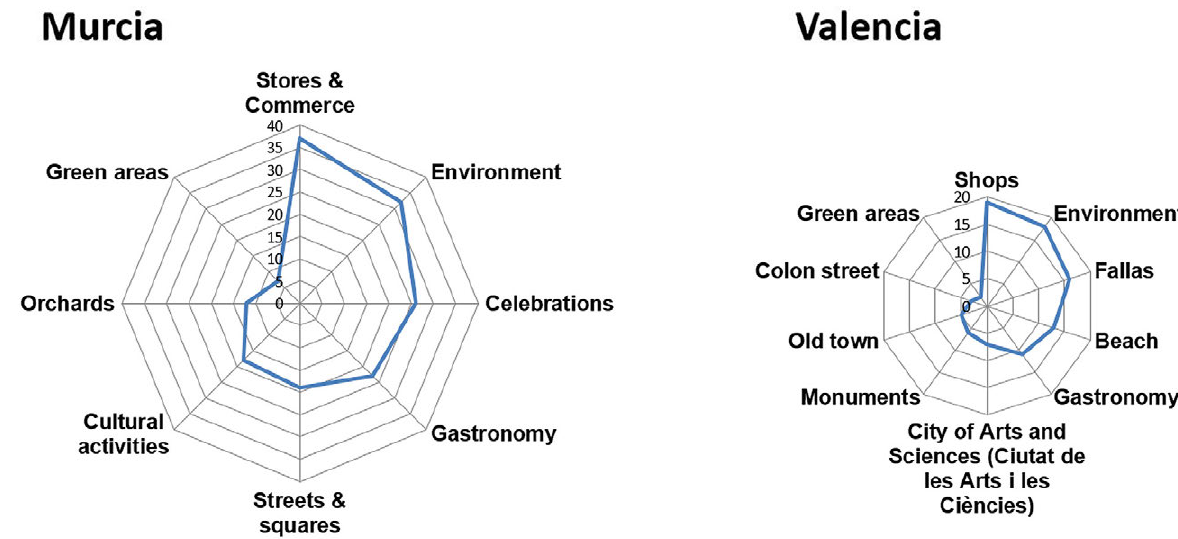
Fig. 9. Elements in Murcia and Valencia that respondents consider they would miss on leaving the